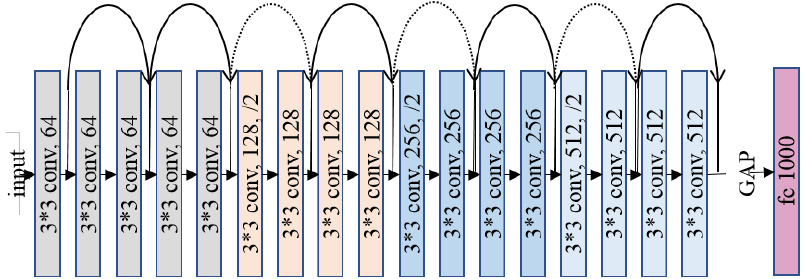
Figure 2. Structure of the ResNet-18. The dotted shortcuts increase dimensions.